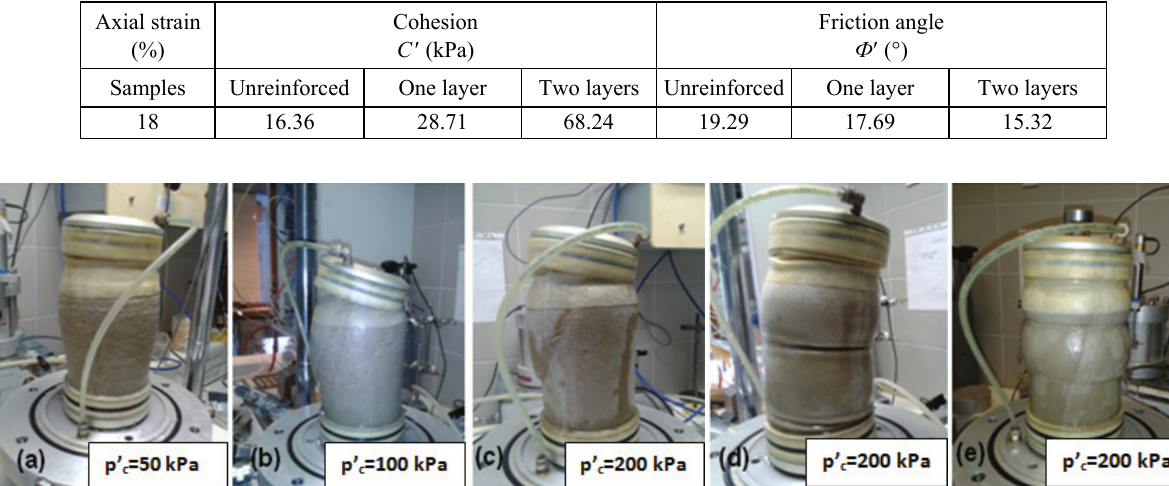
Table 4. Strength parameters values for unreinforced and reinforced sand versus axial strain Axial strain